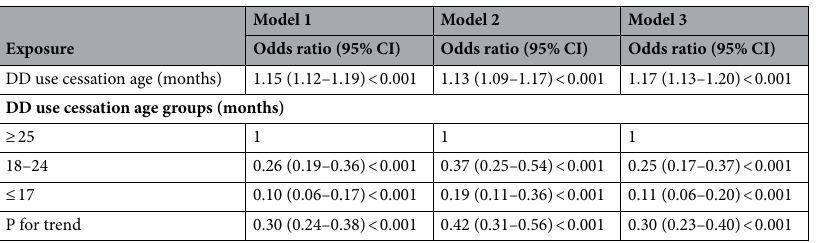
Table 3. Adjusted odds ratios (with 95% confidence intervals) from logistic regression models for the association of age of daytime disposable diaper use cessation with enuresis. Model 1: Crude model, adjust for: None. Model 2: model 1 adjusted for: age (years); education (years); residence; breastfeeding duration (months); family history; anaphylactic disease; constipation; UTI; AITT attitude; AITT practice and TT approach; Model 3: adjusted for: age (years); education (years); residence; breastfeeding duration (months); family history; anaphylactic disease; constipation; UTI, AITT attitude and TT approach. DD disposable diaper, UTI urinary tract infection, AITT assisted infant toilet training, TT toilet